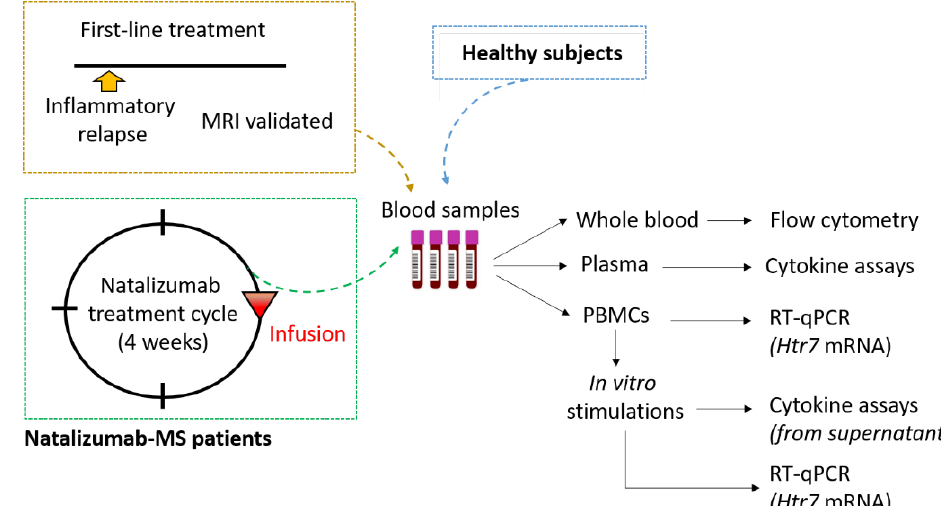
Figure 1. Experimental design and analyses performed. Abbreviations: PBMCs: peripheral blood mononuclear cells; RT: reverse transcription; qPCR: quantitative polymerase chain reaction; mRNA: messenger ribonucleic acid; Htr7 : serotonin 5-HT 7 receptor gene. Table 1. Clinical characteristics of MS patients and healthy subjects. Clinical